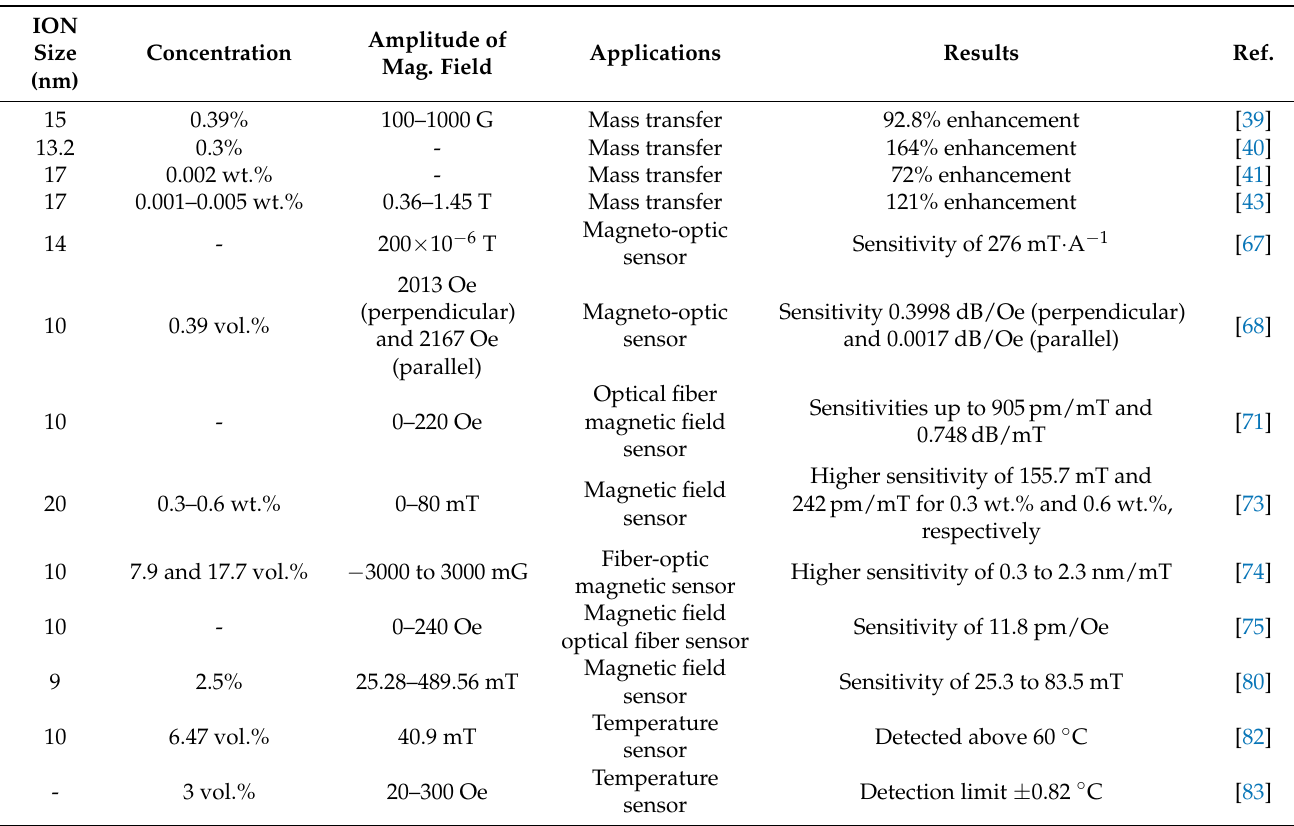
Figure 15. ( A ) Photograph of a practical implementation of an actuator consisting of two hybrid FN seals. Reprinted with permission from Ref. [150]. Copyright 2009, Elsevier; ( B ) Damping of APGW10 ferrofluidic seal as a function of volume (vol.-1: red; vol.-2: green; vol.-3: black; vol.-4: blue; vol.-5: magenta): experimental (dotted lines); model (continuous lines). Reprinted with permission from Ref. [154]. Copyright 2014, Elsevier. Table 1. Specifications of ION-based FNs and their important advanced technological applications concerning engineering fields other than biomedical.